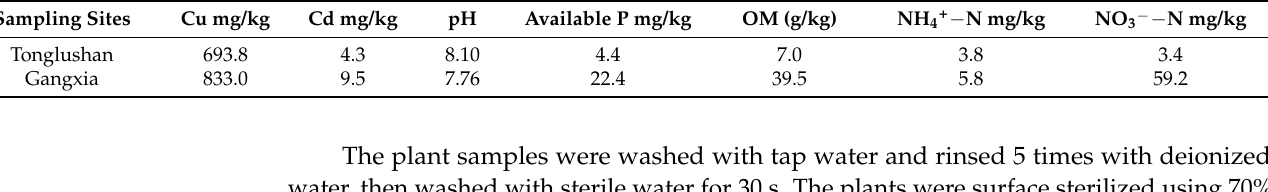
Table 1. The basic characteristics of soils in two sampling